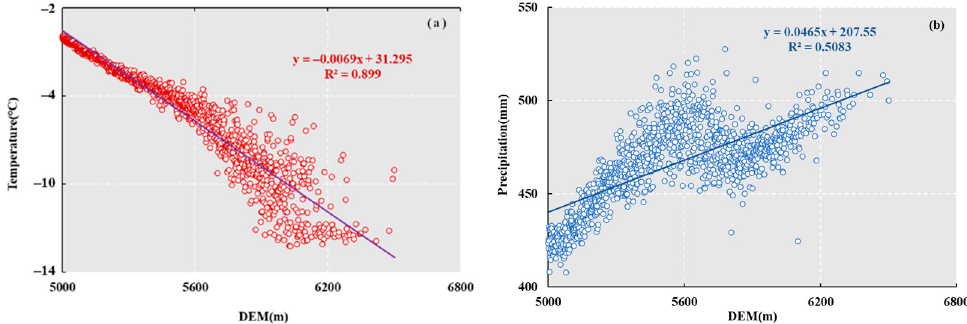
Figure 10. Distribution of temperature ( a ) and precipitation ( b ) at different elevation.